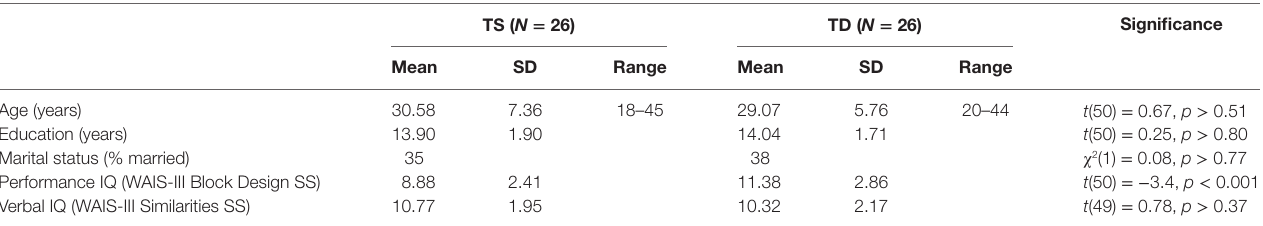
Table 1 | Demographic characteristics of the TS and typically developing